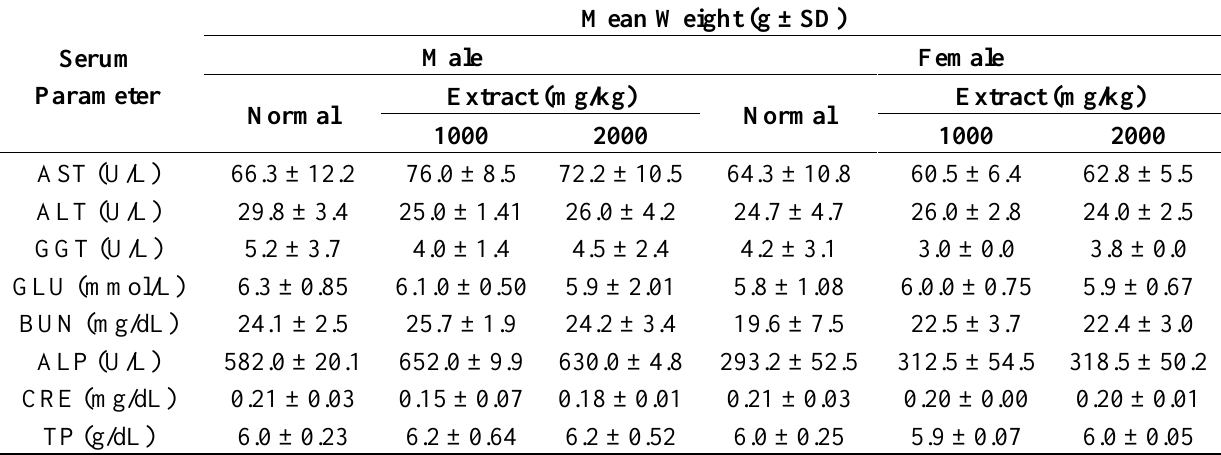
Table 3. Biochemical parameters of rats after 28 days treatment with A. sinensis